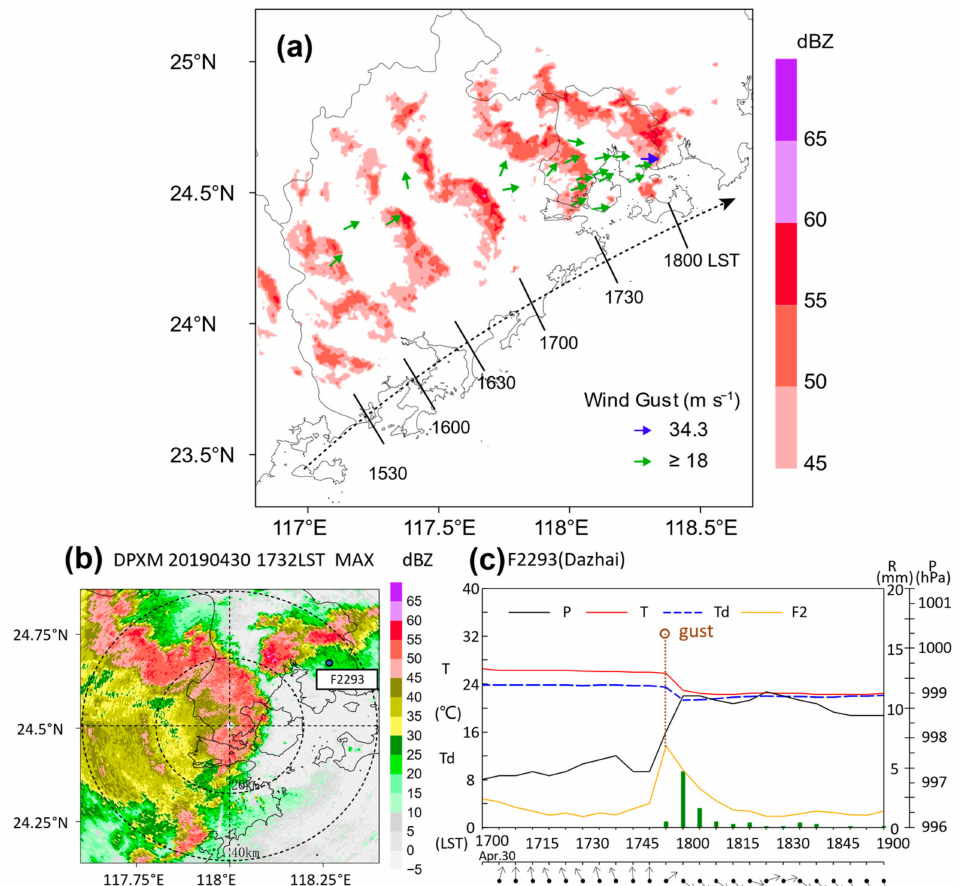
Figure 4. ( a ) The evolution of the bow echo (radar composite reflectivity factor ≥ 45 dBZ) at 30 min intervals between 15:30 and 18:00 LST on 30 April 2019. The wind vector represents gusts ( ≥ 18 m s − 1 ) with different colors. ( b ) Locations of the bow echo and convective cells before merging (shaded, composite reflectivity; unit: dBZ). ( c ) Time series of the two-minute mean wind speed (yellow line; unit: m s − 1 ) and direction (black arrow), the temperature (red line; unit: ◦ C), the dew point temperature (blue dashed line; unit: ◦ C), pressure (black line; unit: ◦ C), and 5 min rainfall (green bars; unit: mm) from AWS F2293 (Dazhai). The peak gust is shown by the brown open